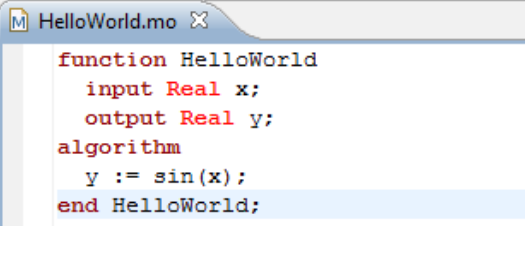
Figure 7: Modelica Code.